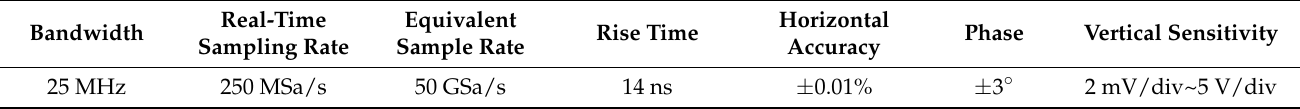
Table 4. Detailed data for the DS 5022M digital